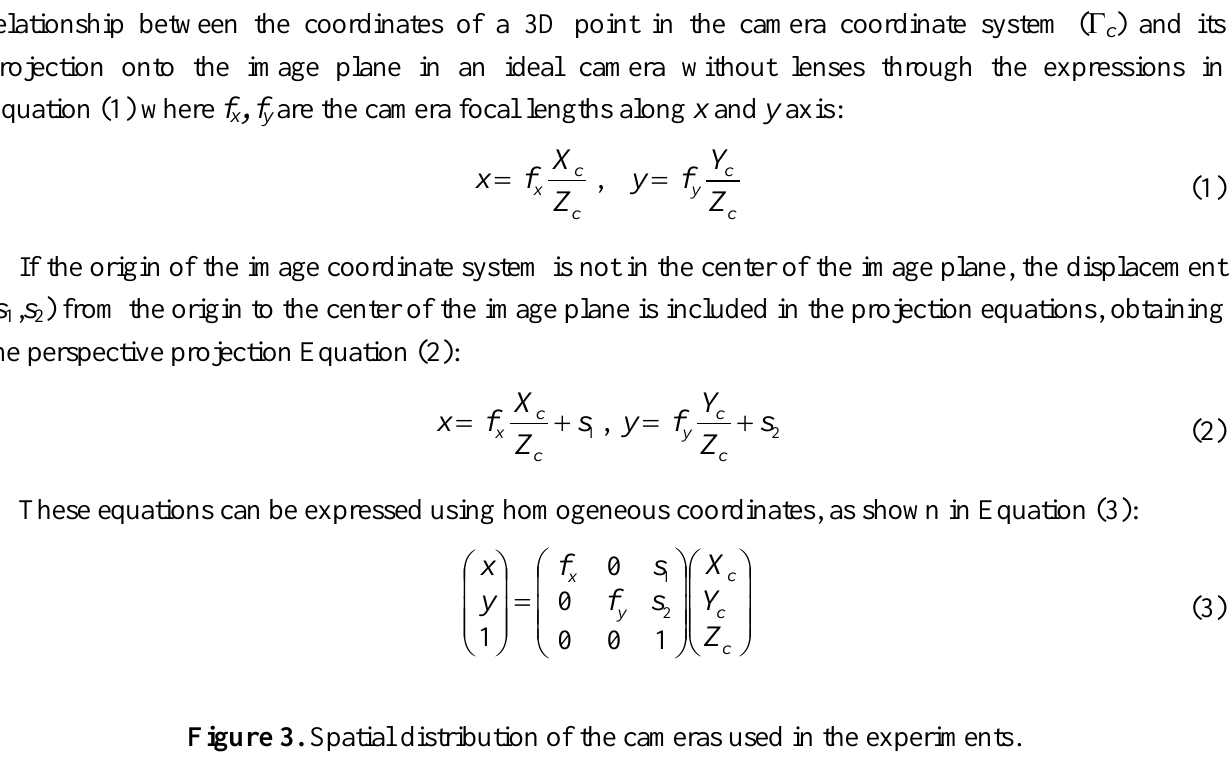
Figure 3. Spatial distribution of the cameras used in the